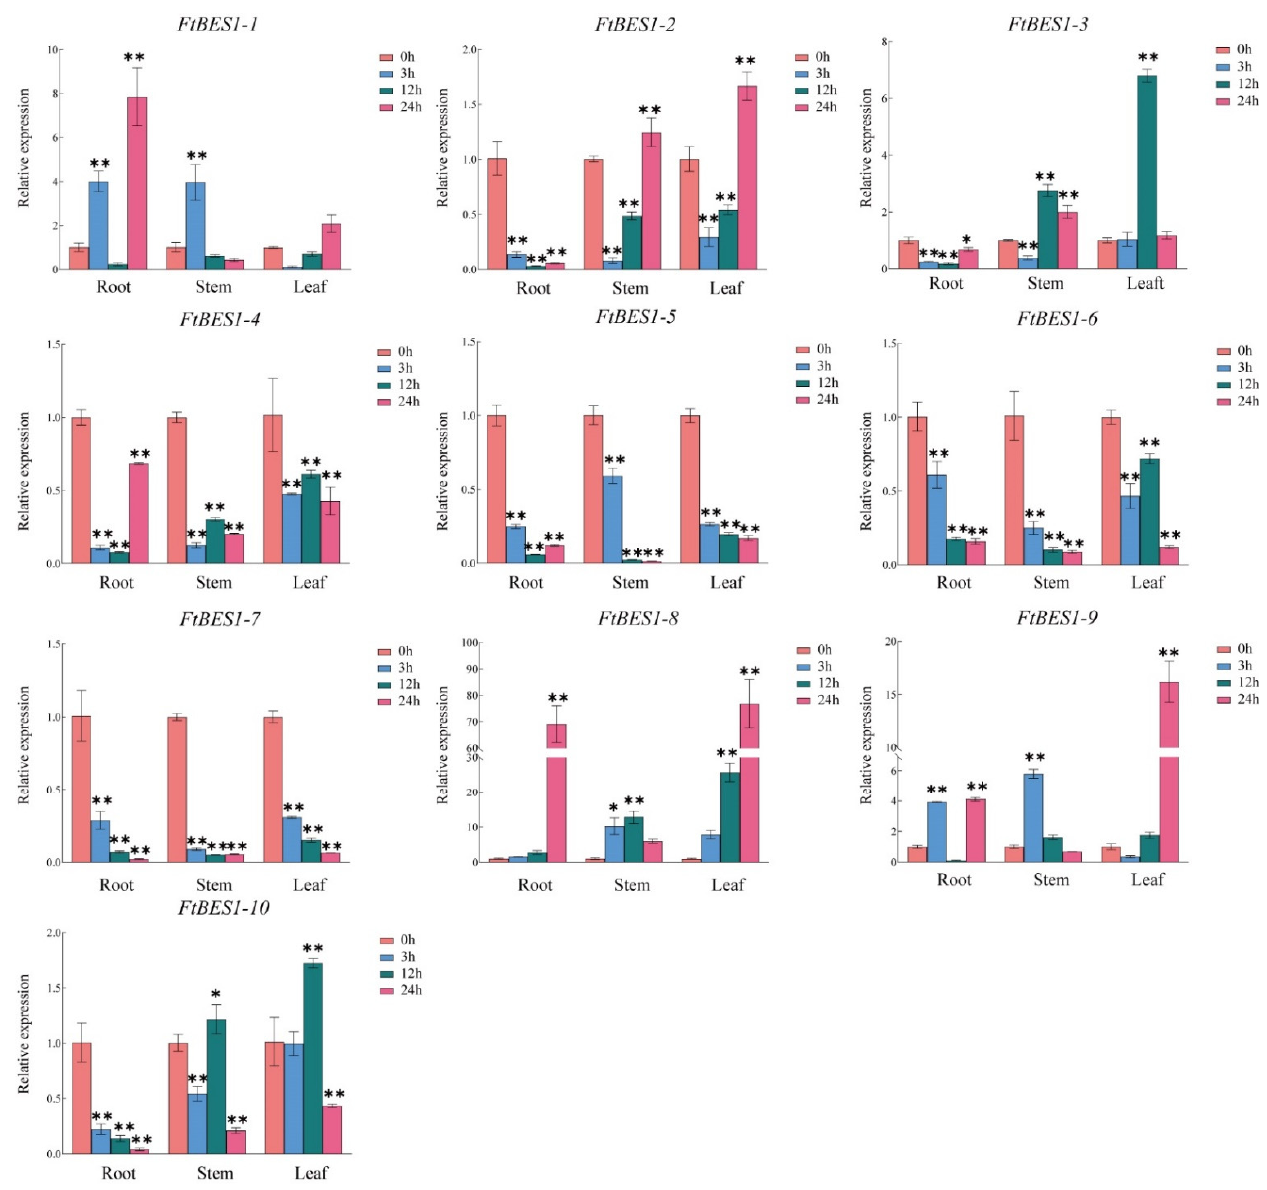
Figure 9. Expression levels of FtBES1 gene in different tissues after 100 μ M SA treatment. Different colors indicate different time of stress treatment. Three biological replicates were considered for each experiment. Error lines indicate standard errors of three independent biological replicates. * In the figure indicates significant differences calculated by t -test (* p < 0.05, ** p < 0.01).